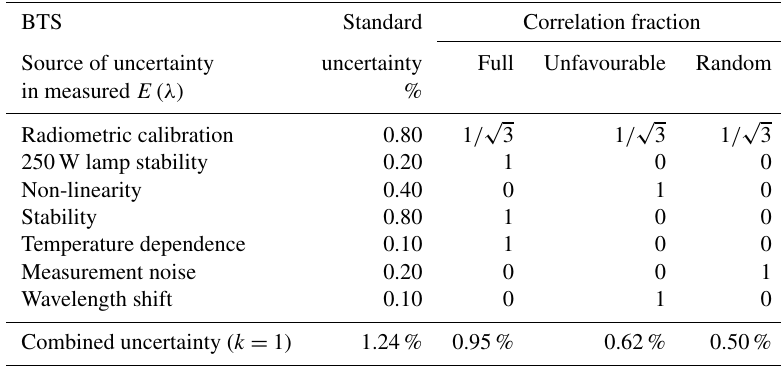
Table 2. Uncertainties in the measurement for the BTS spectroradiometer (Zuber et al., 2018). BTS Standard Source of uncertainty